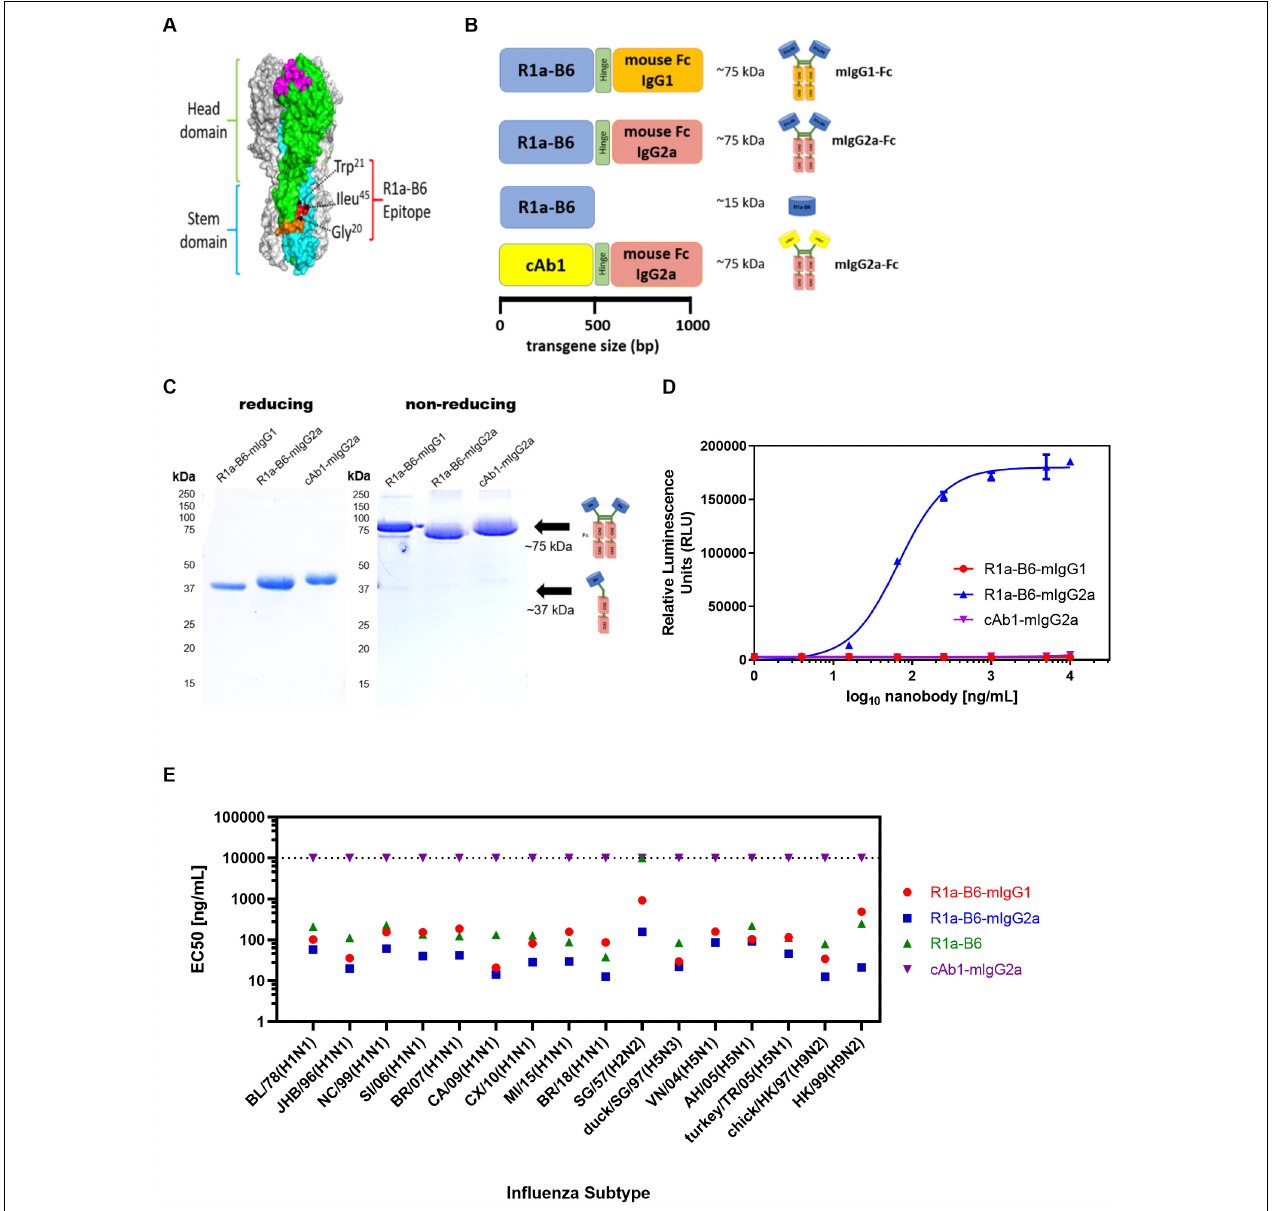
FIGURE 1 | R1a-B6 reformatted for in vivo gene delivery. (A) Surface structure model of hemagglutinin (HA) trimer of A(H1N1)pdm09 (PDB structure 3AL4) showing the key epitope residues of R1a-B6, Gly20, Trp21, and Ile45 (shown in red) located in the HA stem region (cyan) (40). The receptor binding site (magenta), fusion peptide (orange), and head domain (green) are also illustrated. (B) Four constructs, (i) R1a-B6 mouse Fc IgG1, (ii) R1a-B6 mouse Fc IgG2a, (iii) monovalent R1a-B6, and (iv) negative control mouse Fc IgG2a fusion carrying a nanobody, cAb1 [adapted from Arbabi Ghahroudi et al. (54)], specific for chicken egg white lysozyme were produced in vitro . These constructs were cloned into an AAV expression system for protein expression in vivo . (C) Expression and purification of nanobody-Fc fusions. Detection of proteins was carried out under reducing and non-reducing conditions in SDS-PAGE gels. Theoretical molecular weights (MW) for R1a-B6-mIgG1, R1a-B6-mIgG2a, and cAb1-mIgG2a are ∼ 37 kDa under denaturing (reducing) conditions, and ∼ 75 kDA under non-reducing conditions. (D) In vitro ADCC activation. Activation of luciferase reporter gene is shown in relative luminescence units (RLU) as a function of nanobody-Fc concentration. Each well was measured in triplicate. (E) Binding of R1a-B6 against a broad range of influenza A subtypes as tested by ELISA. Half maximal effective concentration (EC 50 ) was measured in duplicate. There was no binding on A/TX/12(H3N2) or B/Brisbane/08 (data not shown). All values above the dotted line indicate no binding activity.